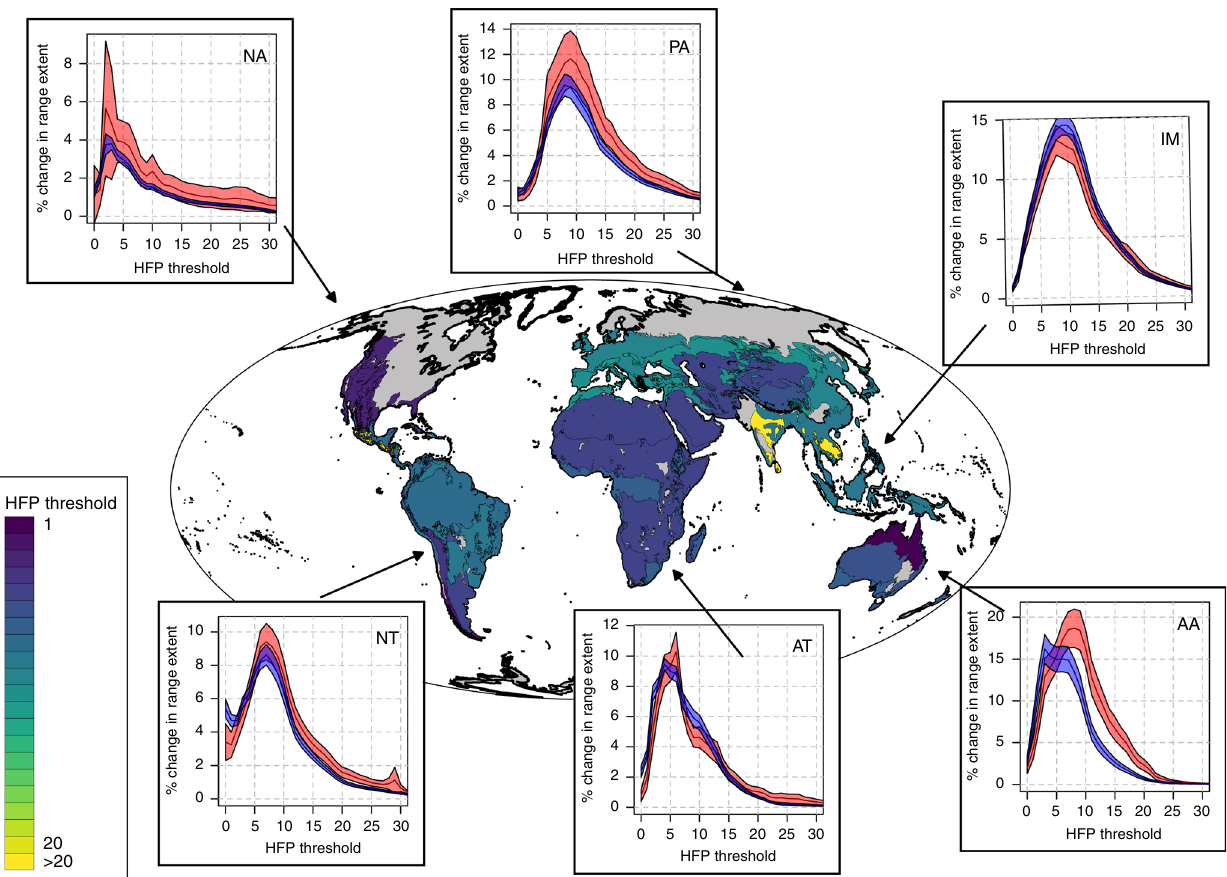
Fig. 6 Changes in the overlap between species ranges and high human footprint (HFP) values for each biogeographic realm*. The underlying map reports, for each biome within each realm, the threshold at which change in HFP values is the highest for high-risk species. The plots report the average change in the overlap between species ranges and HFP values bigger than a given threshold within each realm (with high-risk species in red and low-risk species in blue). The shaded areas around the lines in the plots represent the 95% standard credible interval measured across a total of: 493 AA species, 854 AT species, 604 IM species, 259 NA species, 949 NT species, 442 PA species*. *Realm acronyms: AA Australasia, AT Afrotropical, IM Indomalay, NA Nearctic, NT Neotropical, PA